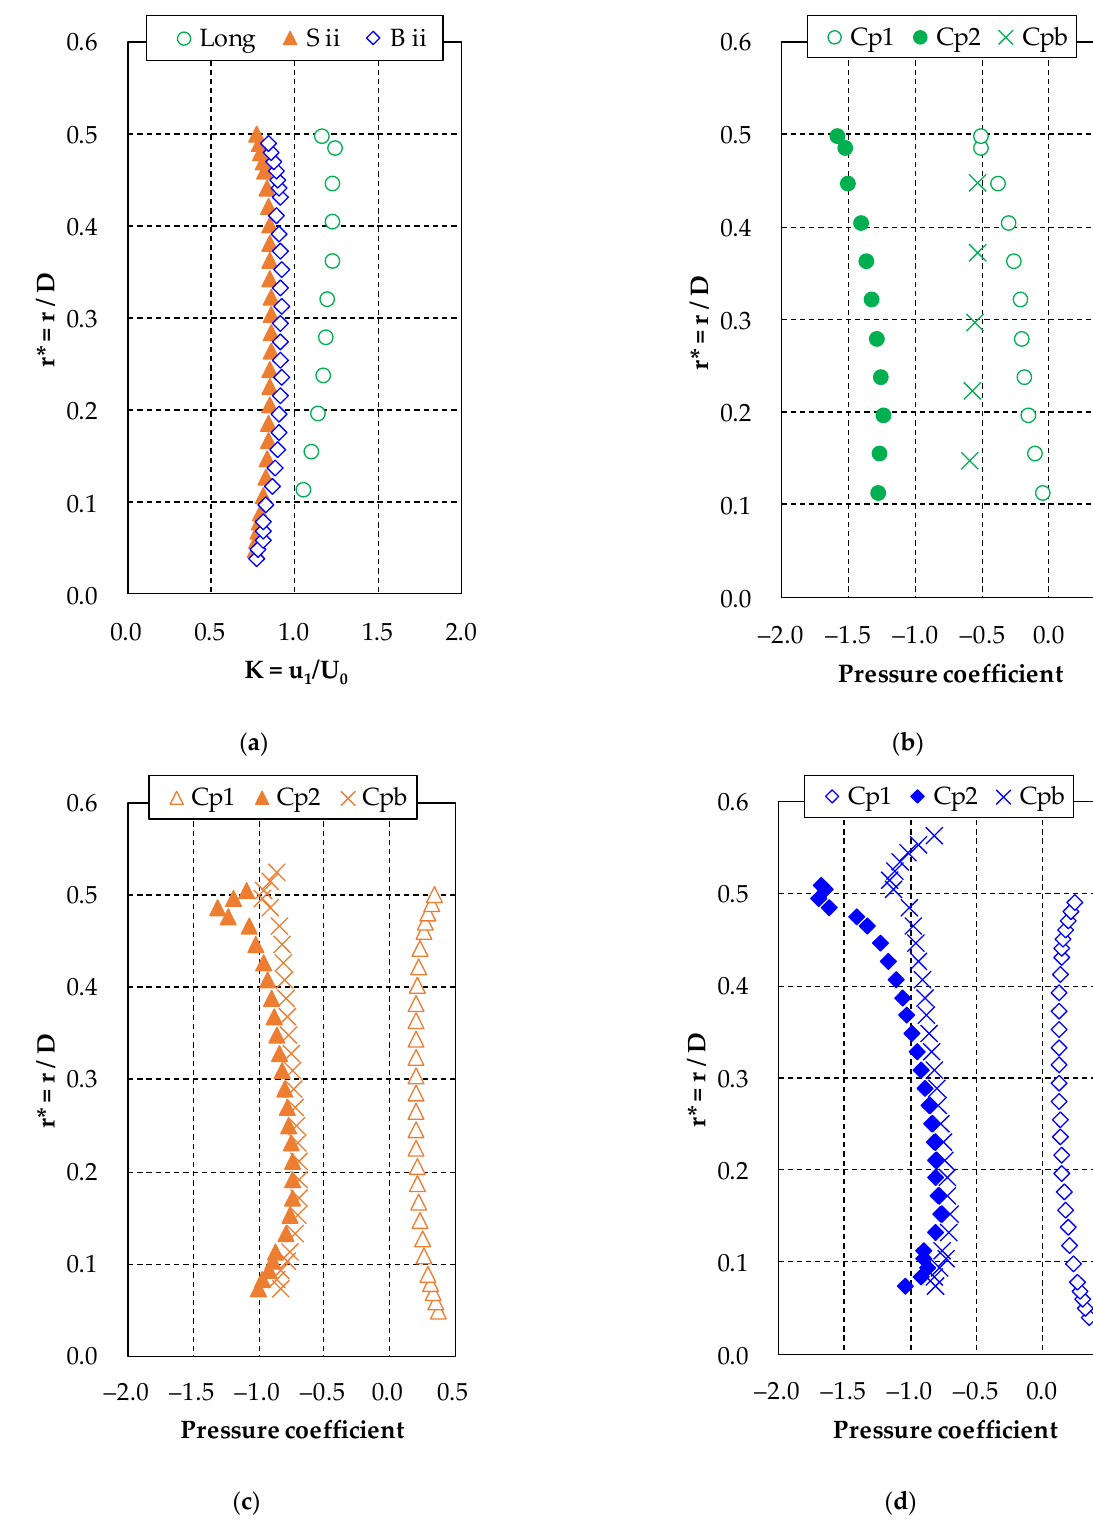
Figure 12. Coefficients measured in wind tunnel experiments: ( a ) inflow velocity ratio K; ( b ) pressure coefficients for the long brimmed diffuser; ( c ) pressure coefficients for Sii brimmed diffuser; ( d ) pressure coefficients for Bii brimmed diffuser.